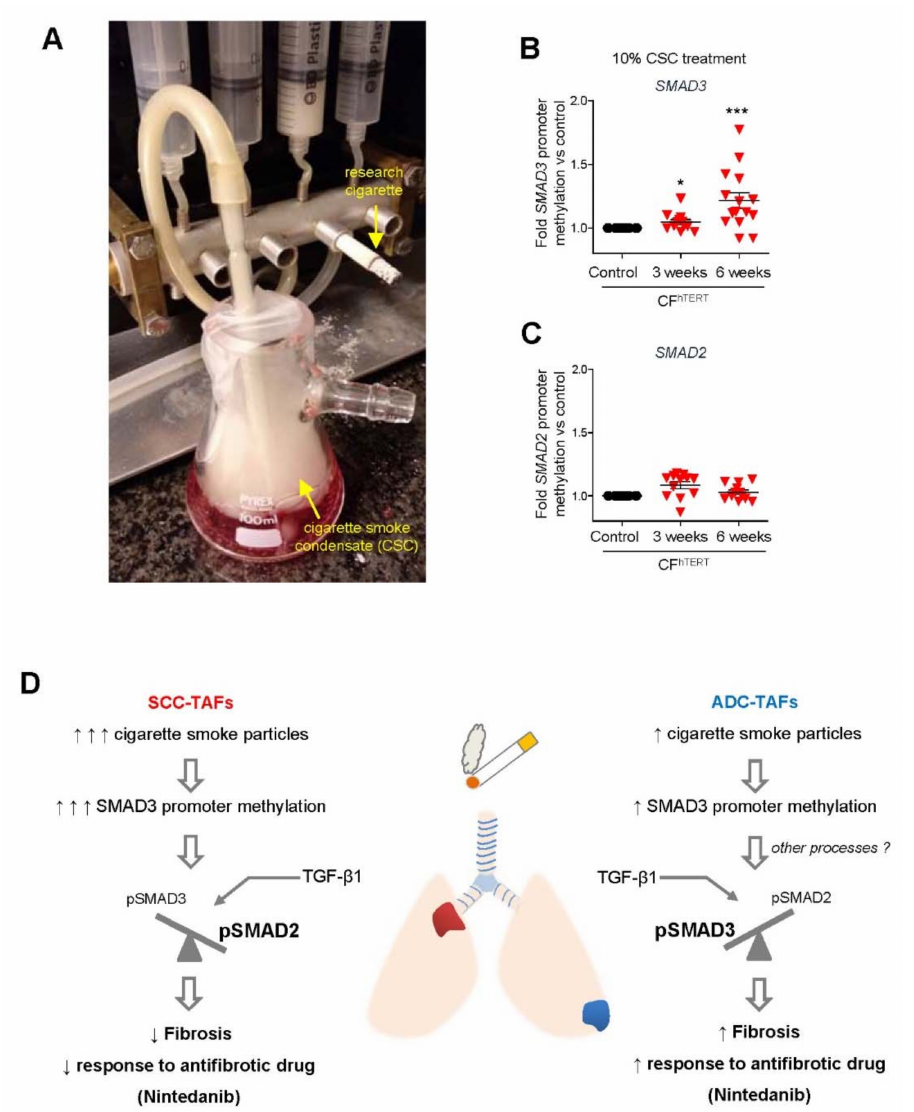
Figure 3. Smoking and SMAD3 epigenetic repression in lung TAFs. ( A ) Picture of the set-up used to obtain cigarette smoke condensate (CSC) to stimulate CFs. ( B , C ) Fold SMAD3 ( B ) and SMAD2 ( C ) Promoter DNA methylation of CFs stimulated with 10% CSC up to 6 weeks assessed by pyrosequencing, revealing that smoking particles are sufficient to increase selectively promoter hypermethylation in SMAD3 but not its closely related homolog SMAD2 . * p < 0.05; *** p < 0.005. ( D ) Outline of the emerging model illustrating the differential relationship between smoking, the anatomic location, SMAD3 hypermethylation in TAFs and their response to the antifibrotic drug Nintedanib in ADC compared to SCC. ( B – D ) Reprinted from [19] with